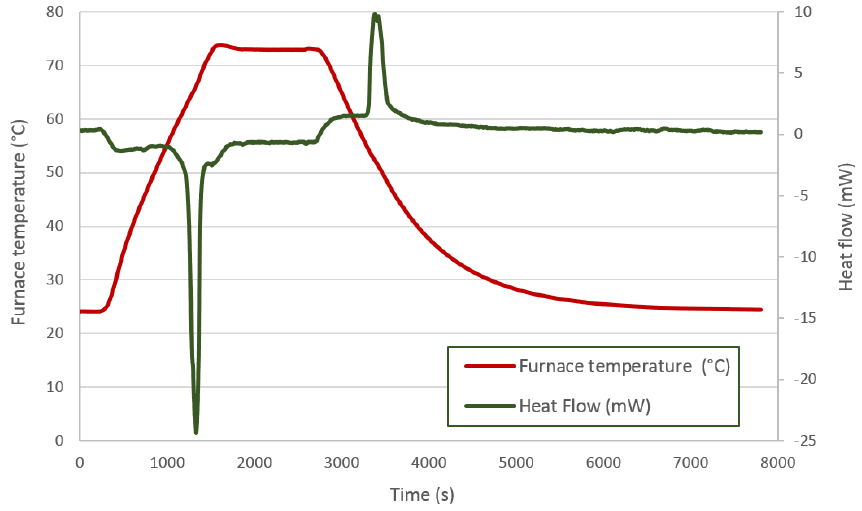
Figure 5. DC58 DSC Figure 5. DC58 DSC analysis.